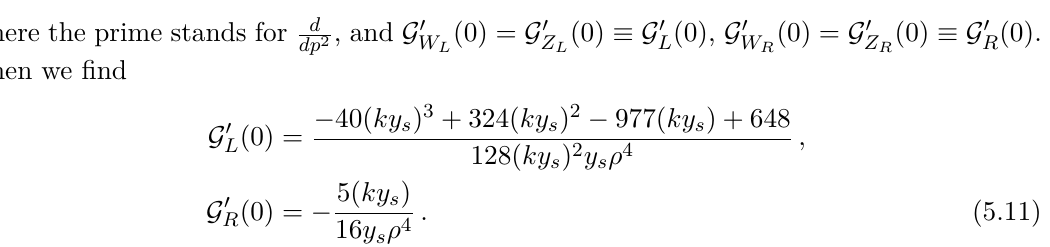
, and G 0 (0) = G 0 (0) ≡ G 0 (0) , G 0 (0) = G 0 (0) ≡ G 0 (0) W L Z L L W R Z R R dp 2